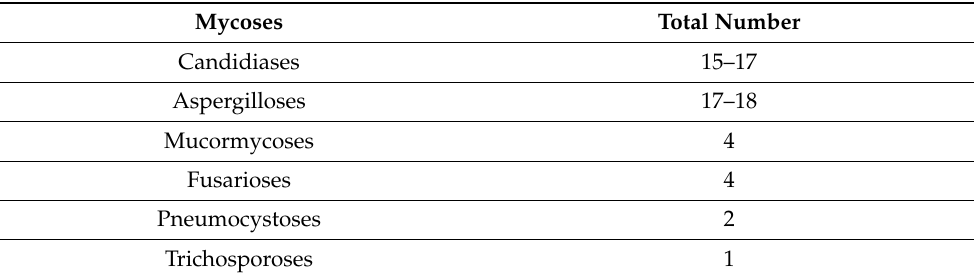
Table 2. Total number of mycoses diagnosed in patients hospitalised in the Greek paediatric haematology-oncology units during the years 2019 and